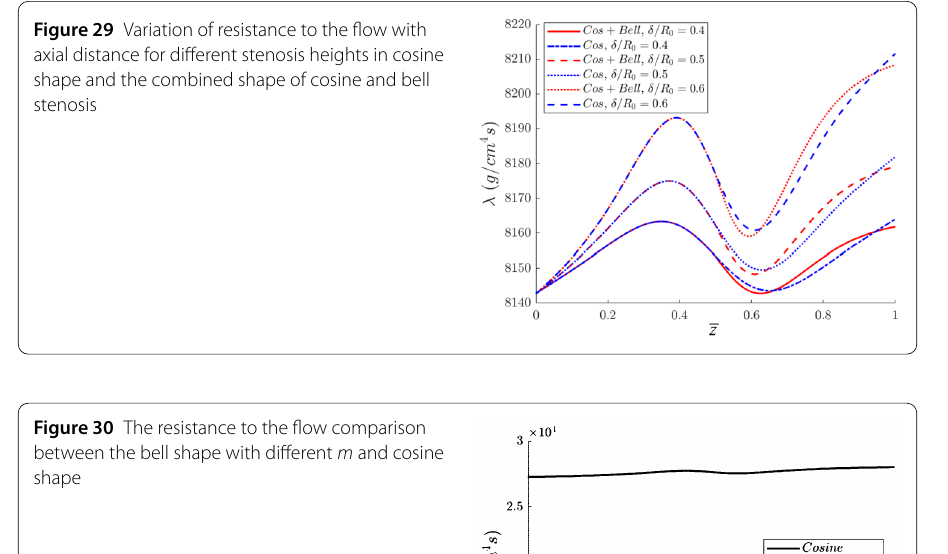
Figure 29 Variation of resistance to the flow with axial distance for different stenosis heights in cosine shape and the combined shape of cosine and bell stenosis